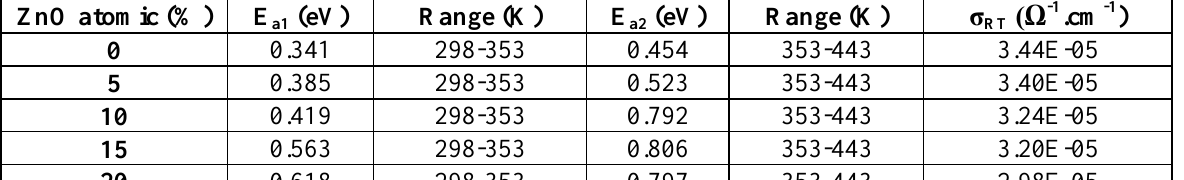
Table 2: Activation energies, thermal ranges and dc conductivity of (SnO films.